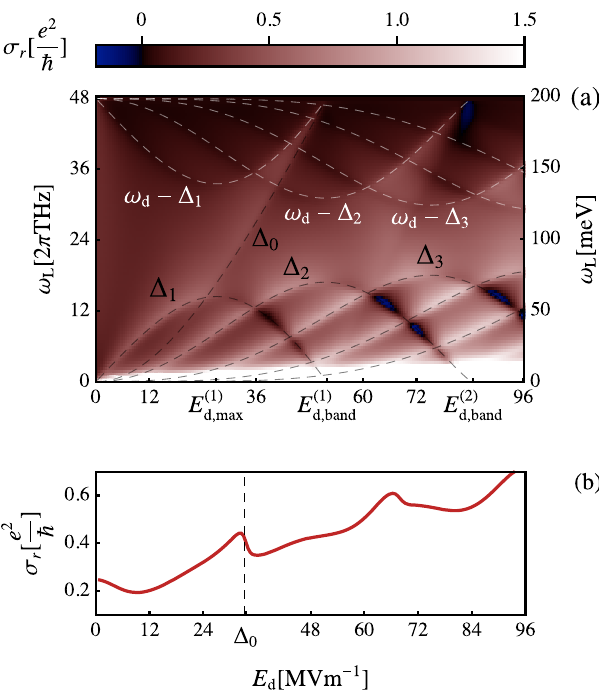
Fig. 2 Longitudinal optical conductivity of light-driven graphene. The real part of the optical conductivity of graphene driven at the frequency ω = 2 π × 48 THz ≈ 200 meV as a function of the driving fi eld strength E d (a) and a cut at half the driving frequency ω L = ω d /2 = 2 π × 24 THz (b). The dashed lines show the various band gaps Δ m as given by Floquet theory. The gap Δ 0 becomes clearly visible above values of ω ≈ 2 π × 14 THz ≈ 60 meV and E L complementary resonant features at ω d − Δ m , with m > 0.